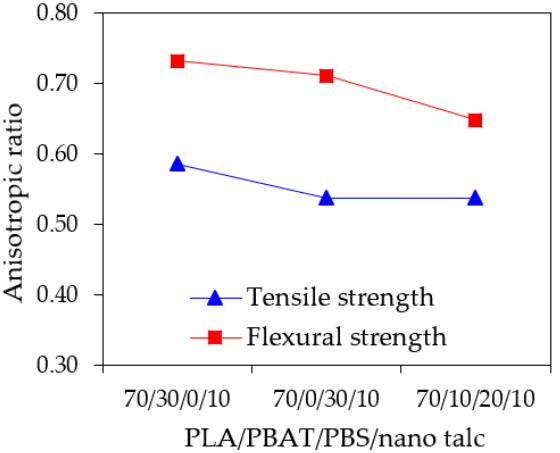
Figure 4. Anisotropic ratio in tensile and flexural strength of PLA/PBAT/PBS/nano talc composite 3D